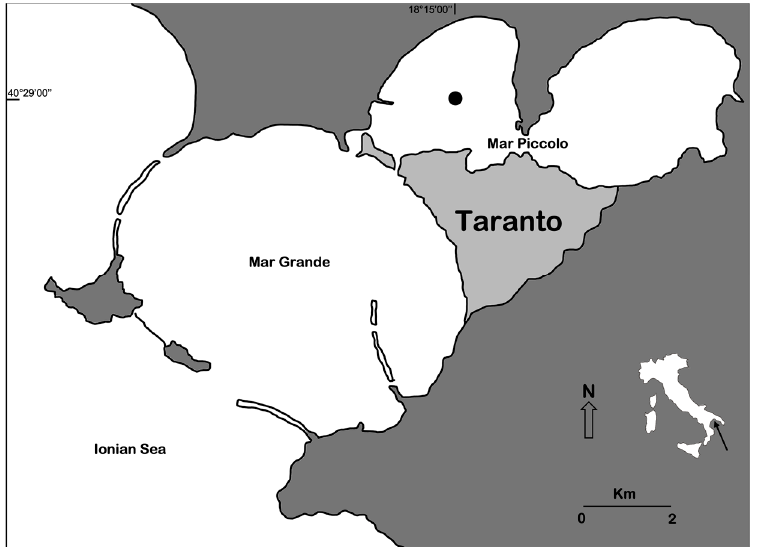
Figure 2. Map of the Taranto sea system with the location of the study site in the center of the First Inlet of the Mar Piccolo.